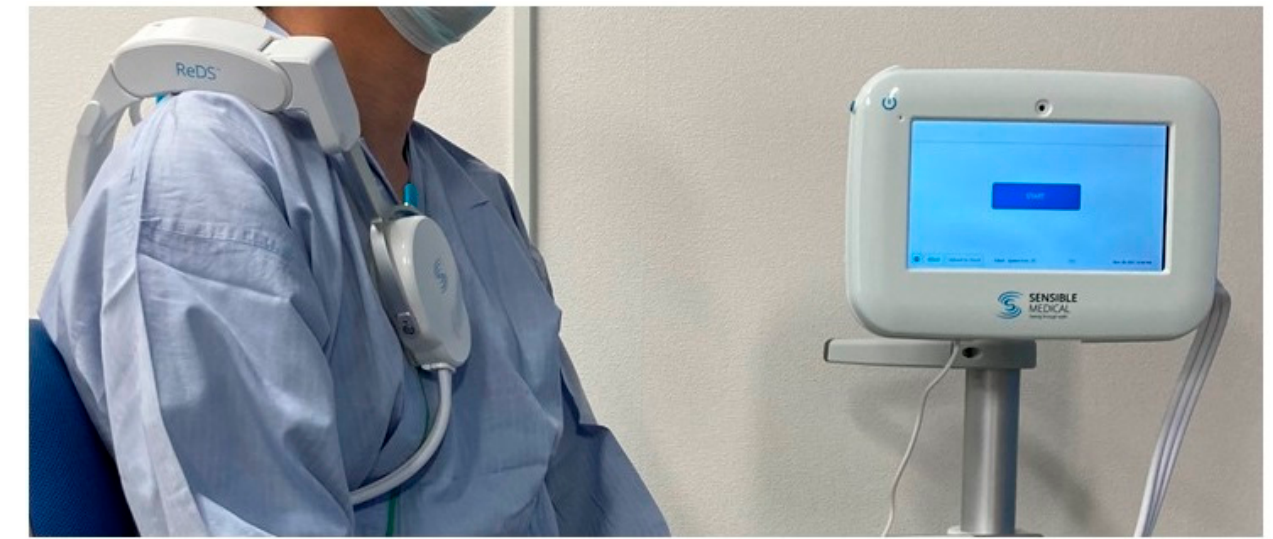
Figure 1. An ReDS system consists of a monitor and a sensor unit [6].